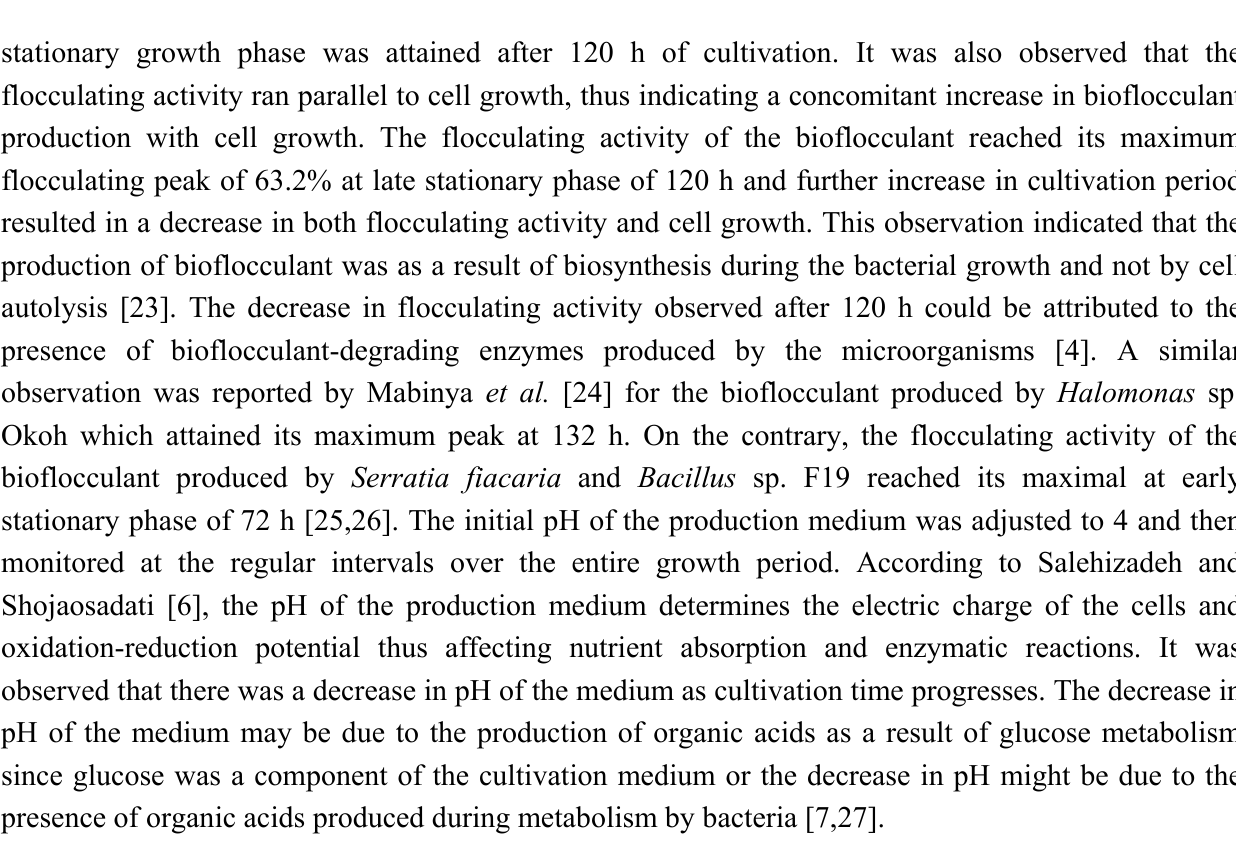
Figure 1. Time course for bioflocculant production by a mixed culture of Halomonas sp. Okoh and Micrococcus sp.